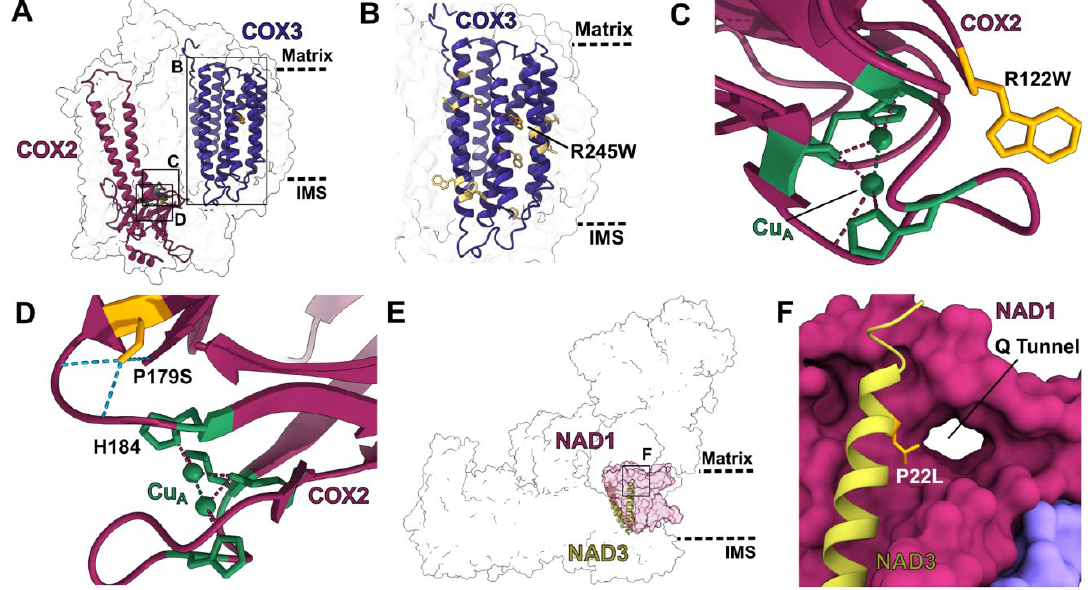
Figure 3. Structural characterization of edits by select multi-site PPR proteins: ( A ) Overall position of the edits produced by PPR protein PpPPR_77 in V. radiata complex IV (PDB: 7JRO). Edited subunits are shown in colored cartoon. Insets show the positions of panels ( B – D ). ( B – D ) Structural details of edited residues. Edited residues are shown in orange stick representation. ( B ) COX3 (cid:48) s transmembrane region (dark purple cartoon). COX3 (cid:48) s residue 245 is edited from arginine to tryptophan (R245W), removing a positively charged residue from the hydrophobic environment of the membrane. Other edited residues in COX3 (cid:48) s transmembrane region are shown in light yellow stick. Approximate location of the matrix and IMS are shown in dashed lines. ( C ) Copper site for electron transfer from cytochrome c (not shown) in COX2 (maroon cartoon). Copper atoms of Cu A center are shown in green, with coordinating residues in green stick and coordination bonds in dashed lines. COX2 (cid:48) s residue 122 is edited from arginine to tryptophan (R122W). The positive charge of the arginine would alter the electronic environment of the Cu A center. ( D – F ) Structural details of edits produced by PPR protein DEK10 in V. radiata complex IV and A. thaliana complex I. ( D ) Cu A site of COX2 as in panel ( C ). DEK10 edits COX2 (cid:48) s residue 179 from proline to serine (P179S). Serine-19 forms multiple hydrogen bonds (light blue dashed lines) that position the loop that leads to Cu A -coordinating residue histidine- 184 (H184). ( E ) Overall position of the DEK10 edit in A. thaliana complex I (PDB: 7AR8). Edited subunit (NAD3) is shown in light green cartoon. Interaction subunit (NAD1) is shown in magenta surface. Inset shows the position of panel ( F ). ( F ) NAD3 (cid:48) s interface with NAD1 at the entrance of the Q tunnel, through which complex I’s substrate quinone enters its active site. DEK10 edits NAD3 (cid:48) s residue 22 from proline to leucine (P22L). A proline in this position would break the helix,